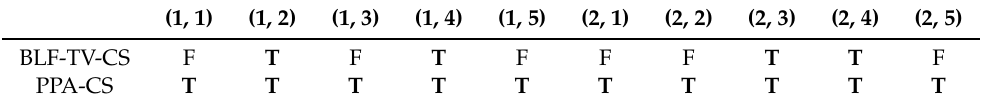
Table 2. Comparison of different image segmentation methods as to whether the estimated shape of the foreground region of each image shown in Figure 3a was convex from vision, where the notation ( i , j ) corresponds to the image shown in Figure 3a ( i , j ) ( i = 1 : 5, j = 1 : 2 ) and the notation “T” means the corresponding estimated shape was convex. Otherwise, the notation “F” was given.